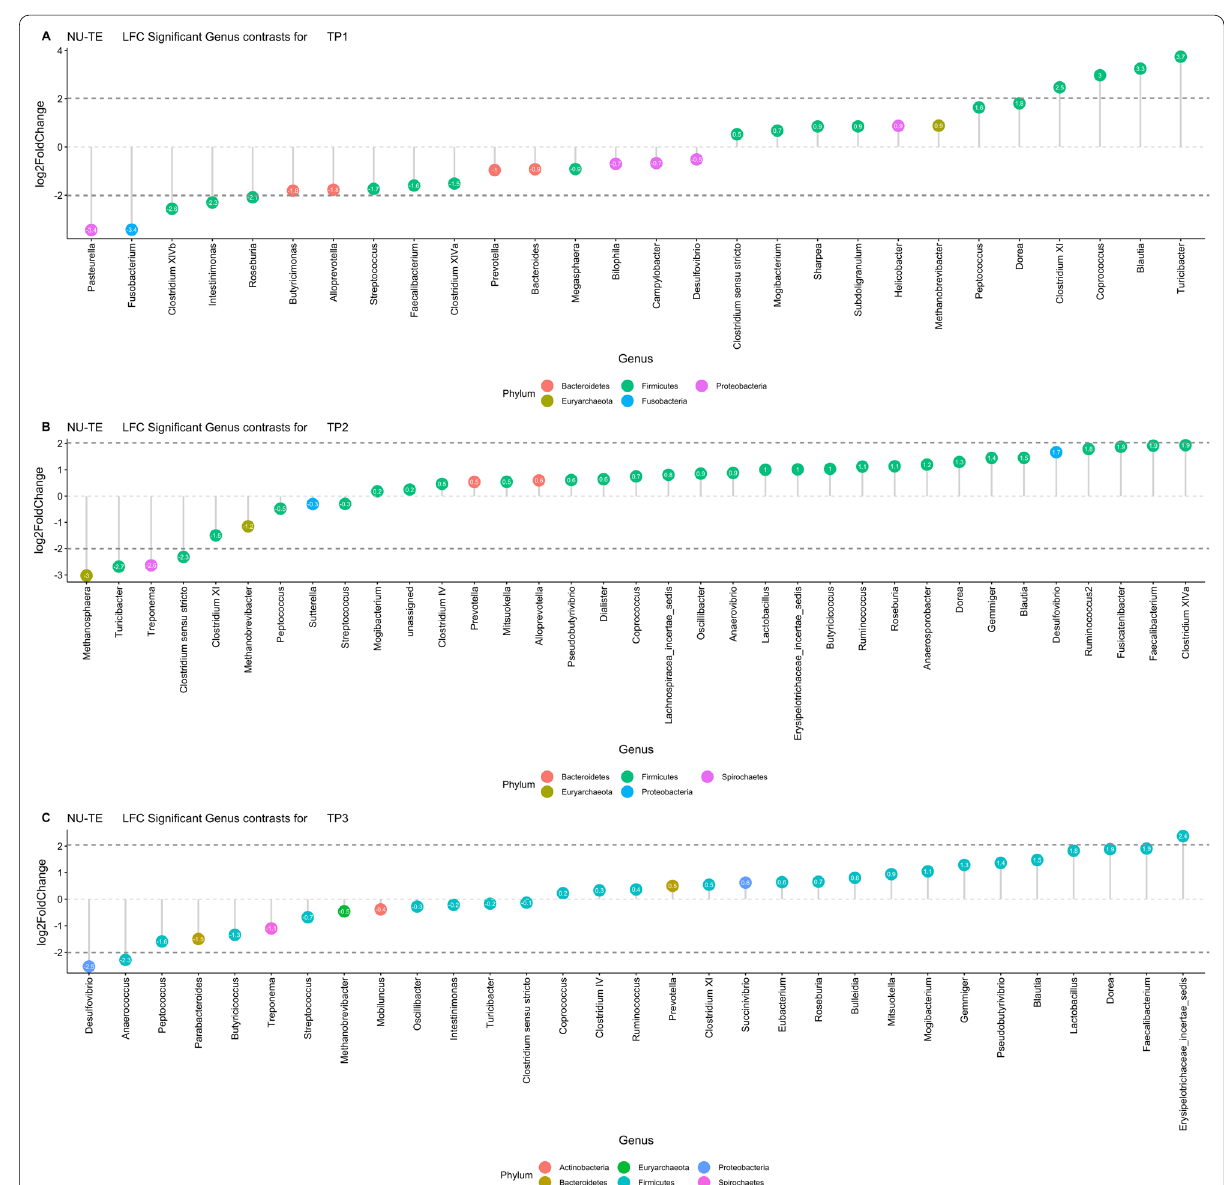
Fig. 5 Genera differential abundance between NU and TE systems for the three sampling points. Results are expressed as Log2FoldChange (LFC) for Nucleus (NU), and Commercial (TE) at three time points: weaning (TP1 a ), mid test (TP2 b ), and off test (TP3 c ) of the feeding